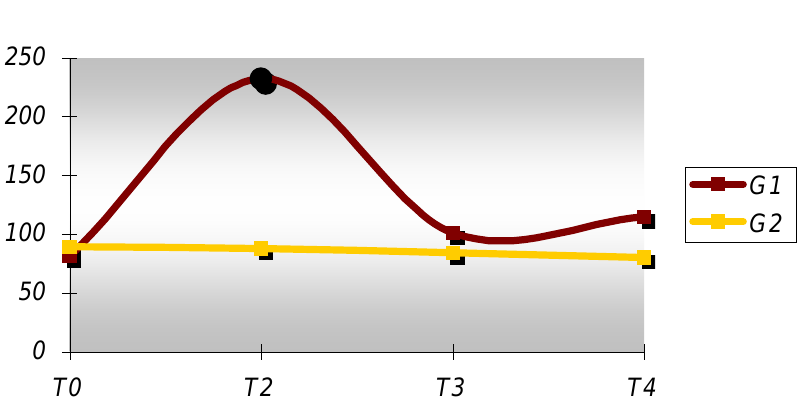
Figure 6: Seric levels of creatine kinase MB (U/L) in both groups of dogs observed (G1 = 0.25 mg/kg and G2 = 0.4 mg/animal) at the different moments studied (T0 = pre-envenomation; T2 = 6h after envenomation; T3 = 24h after envenomation; and T4 = 72h after envenomation) (cid:122) = p <0.05. Botucatu, São Paulo, Brazil, 2003.